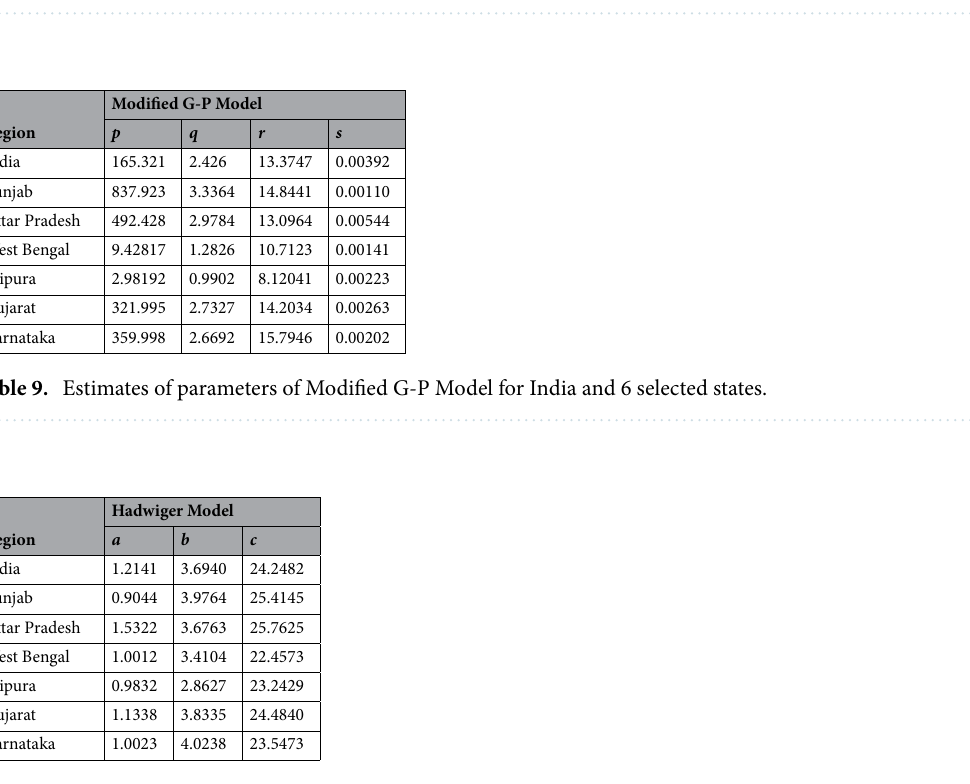
Table 8. Estimates of parameters of Modified Skew Normal Model for India and 6 selected states.